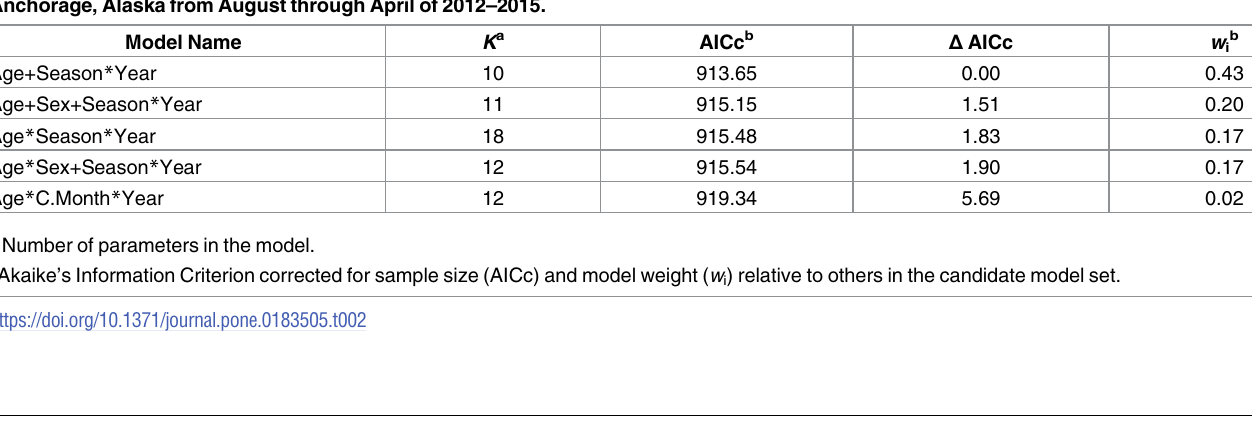
Virus isolation yielded isolates from 6% of the 1062 mallards included in the analysis of IAV prevalence, with isolates from 3% of mallards in 2012/13, 5% of mallards from 2013/14, and 8% of mallards during 2014/15 (Table 1). Across sampling years, only H3N8 was isolated in every year of the study and H4N6 and H12N5 were isolated from mallards in Fairbanks dur- ing 2013/14 and Anchorage in 2014/15 (Fig 1). In Fairbanks, additional IAV subtypes isolated